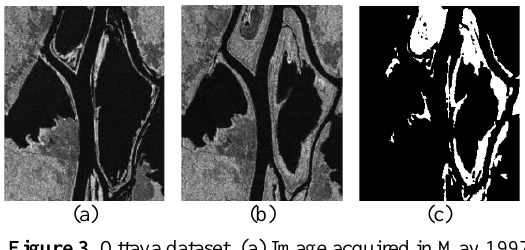
Figure 3. Ottava dataset. (a) Image acquired in May 1997, during the summer flooding. (b) Image acquired in August 1997, after the summer flooding. (c) Ground truth.